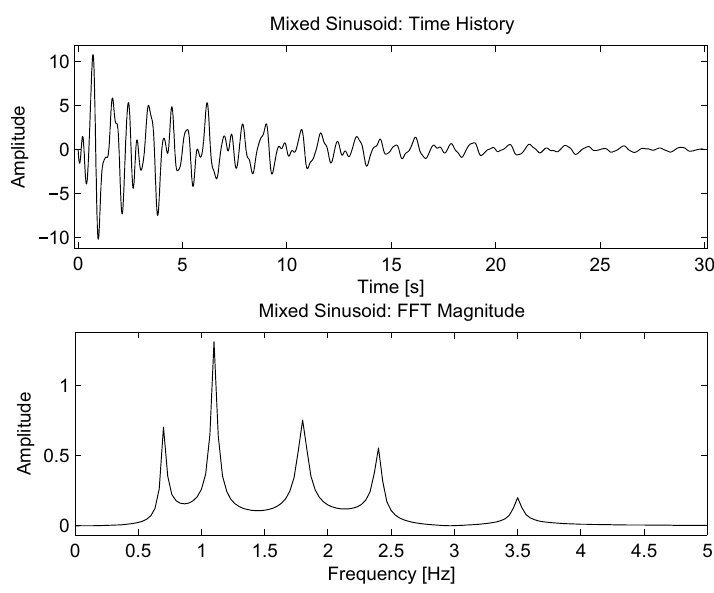
Fig. 6. Mixed damped sinusoid (top) and FFT magnitude (bottom) – ku ex = 8.64.